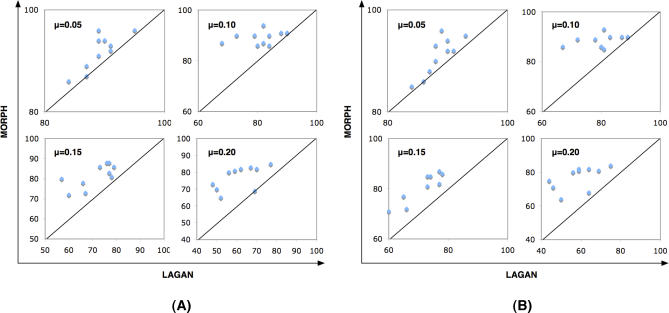
Alignment Sensitivity (A) and Specificity (B) of LAGAN and Morphalign(A) Sensitivity and (B) specificity of LAGAN and Morphalign on experiment sets with simulation parameters μI = μD = 0.2 are shown. Diagonal lines represent equal scores.